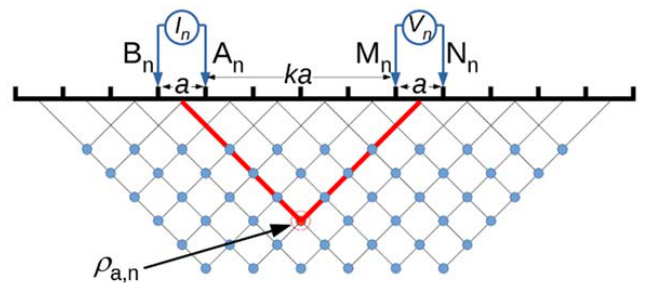
Figure 1. Schematic depiction of the characteristics of a dipole ‐ dipole electrode device used to perform a 2D geoelectrical profile and the rule used to construct an apparent resistivity pseudosection.